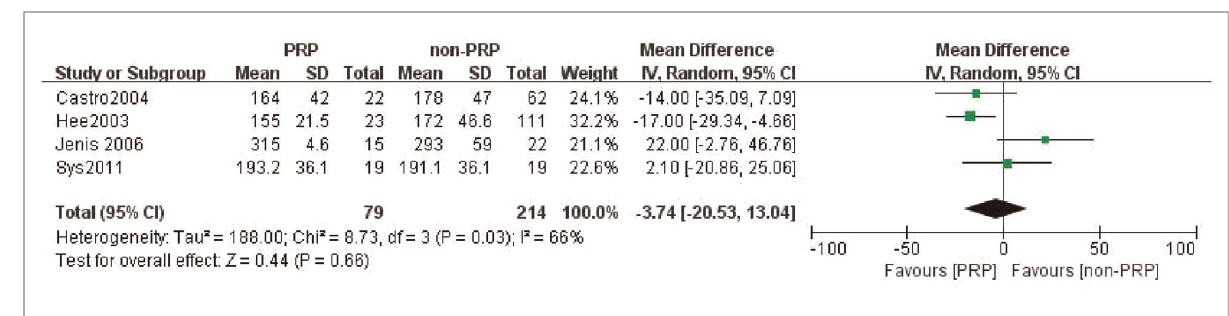
FIGURE 7 Forest plot of the operation time.